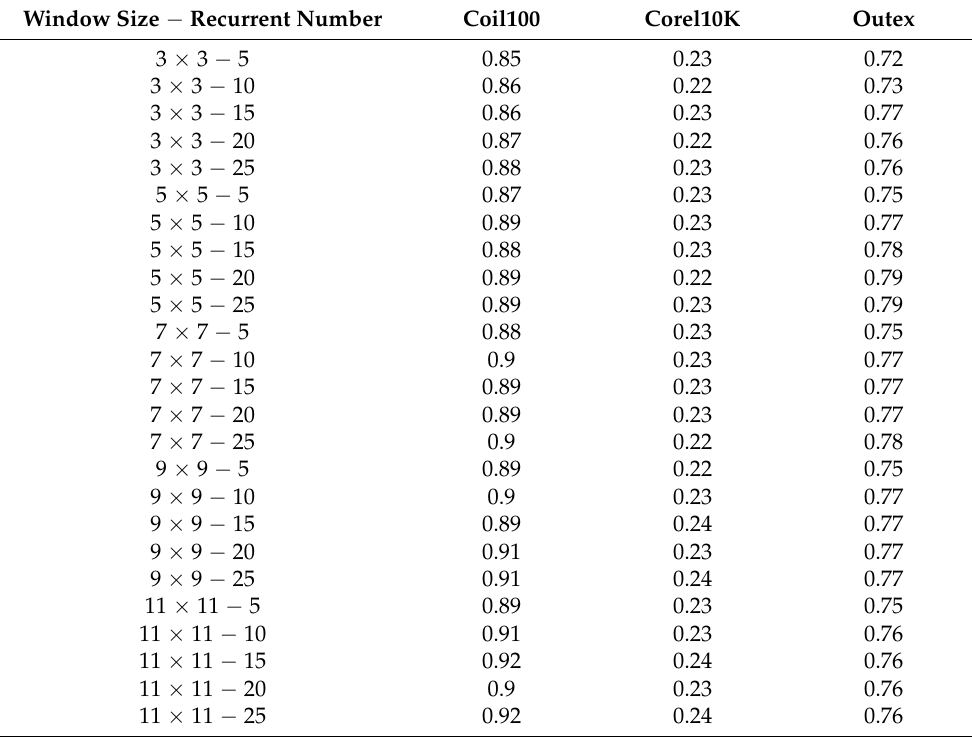
Table 4. Presents accuracies for the various window sizes and transformations for the three datasets using DT.